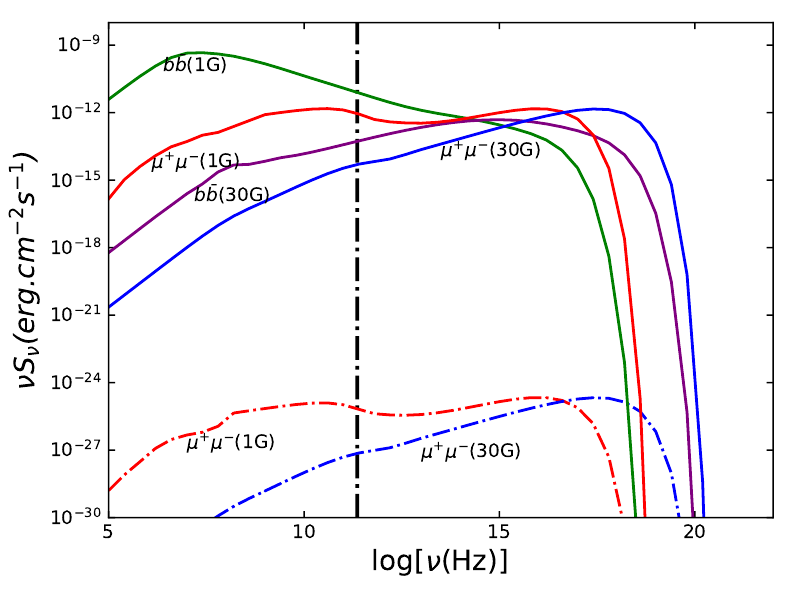
Figure 2 . Spectra of synchrotron emission from DM annihilation, for b ¯ b and µ + µ − channels and magnetic field of 1 G and 30 G (solid lines). The DM mass and cross section are chosen as m χ = 100 GeV and h σv i = 10 − 30 cm 3 s − 1 . For comparison, the contribution of regular NFW profile for µ + µ − channel are also shown (dot-dashed lines). The vertical dot-dashed line corresponds to the observational frequency, i.e., 230